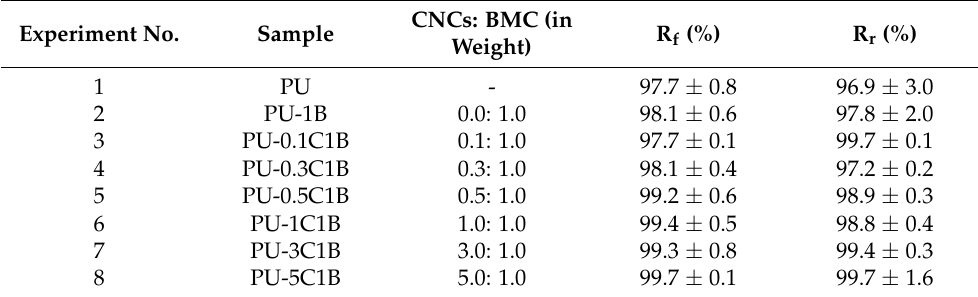
Table 4. The shape fixation rate and shape recovery rate of the 3D-printed PU/nanocellulose shape memory composites compared with the pure PU (table reproduced from